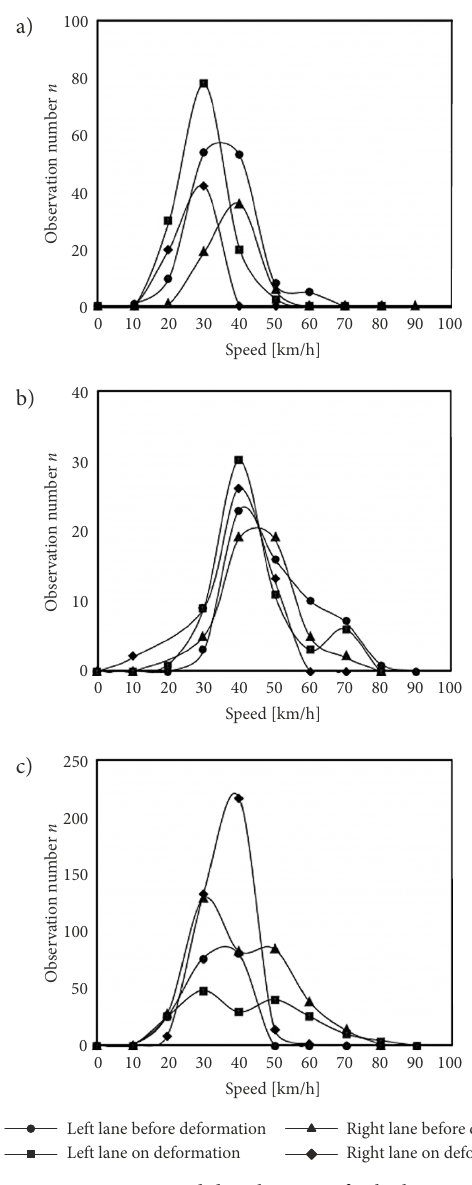
Figure 5. Speed distributions of vehicles on DZ: a – before DZ; b – on DZ; c – after